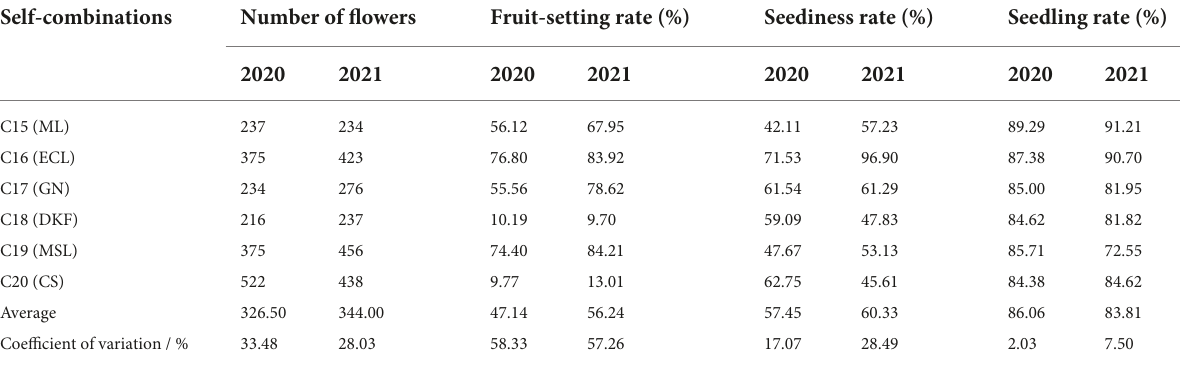
TABLE 3 Fruit-setting rate, seediness rate and compatibility index of hybrid combinations. Cross combination ( ♀